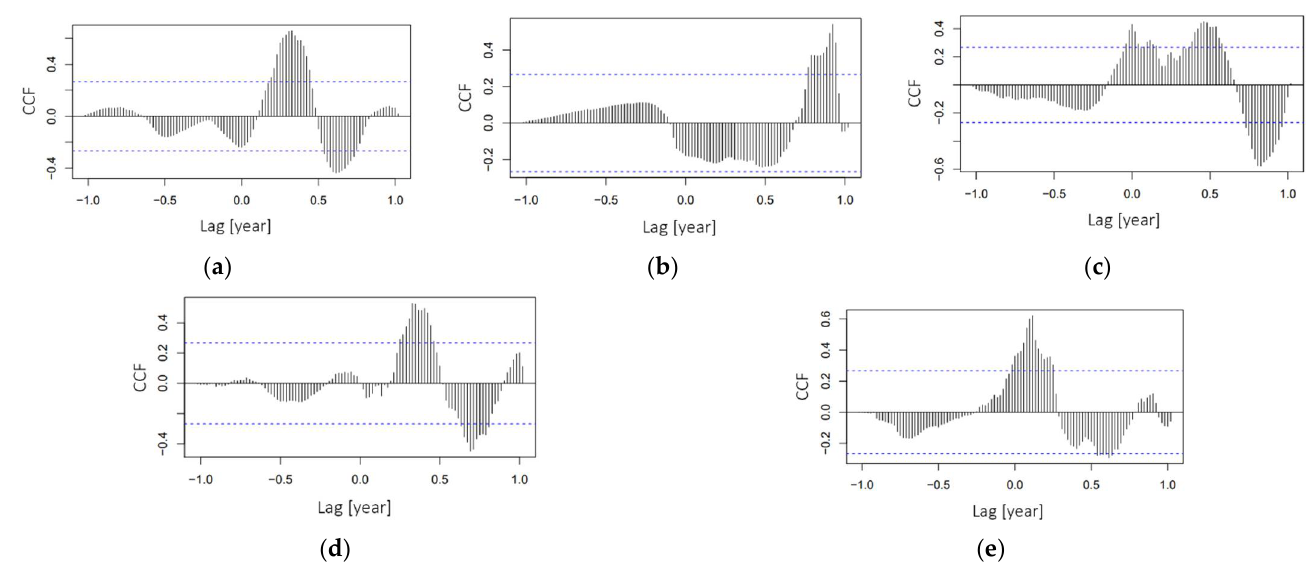
Figure 3. Cross-correlation plots for: ( a ) “covid”–“flu”; ( b ) “covid”–“bcg”; ( c ) “covid”–“hpv”; ( d ) “covid”–“pneumo”; ( e ) “covid”–“polio”.